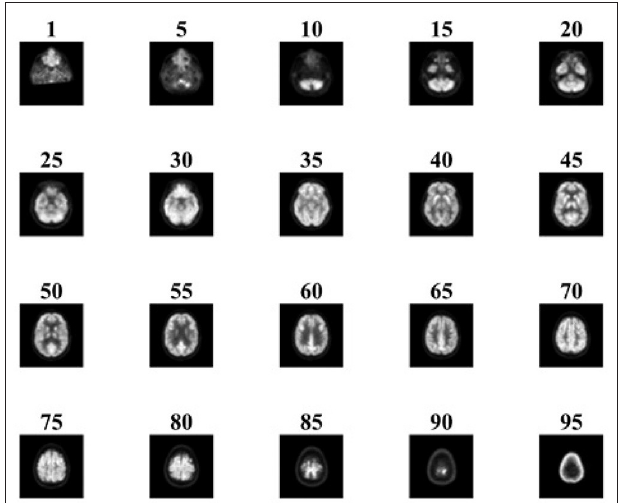
FIGURE 6 | Sample slices of NC